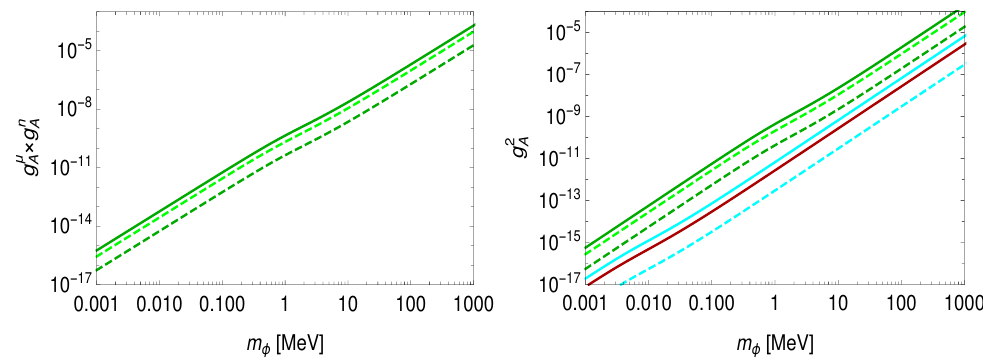
Figure 4 . Left plot: sensitivity to a new dark axial force coupled to protons and muons of the HFS measurement on µ H. Dark green lines correspond to the 2 s HFS and light green dashed the projection for the 1 s HFS measurement proposed by the FAMU experiment, see table 2 for details and references. Dashed lines correspond to projected future improvements. Right plot: comparison between the muonic measurements and other HFS measurements on hydrogen (cyan solid and dashed, see table 2) and muonium µe [64] (brown solid line) assuming that g A